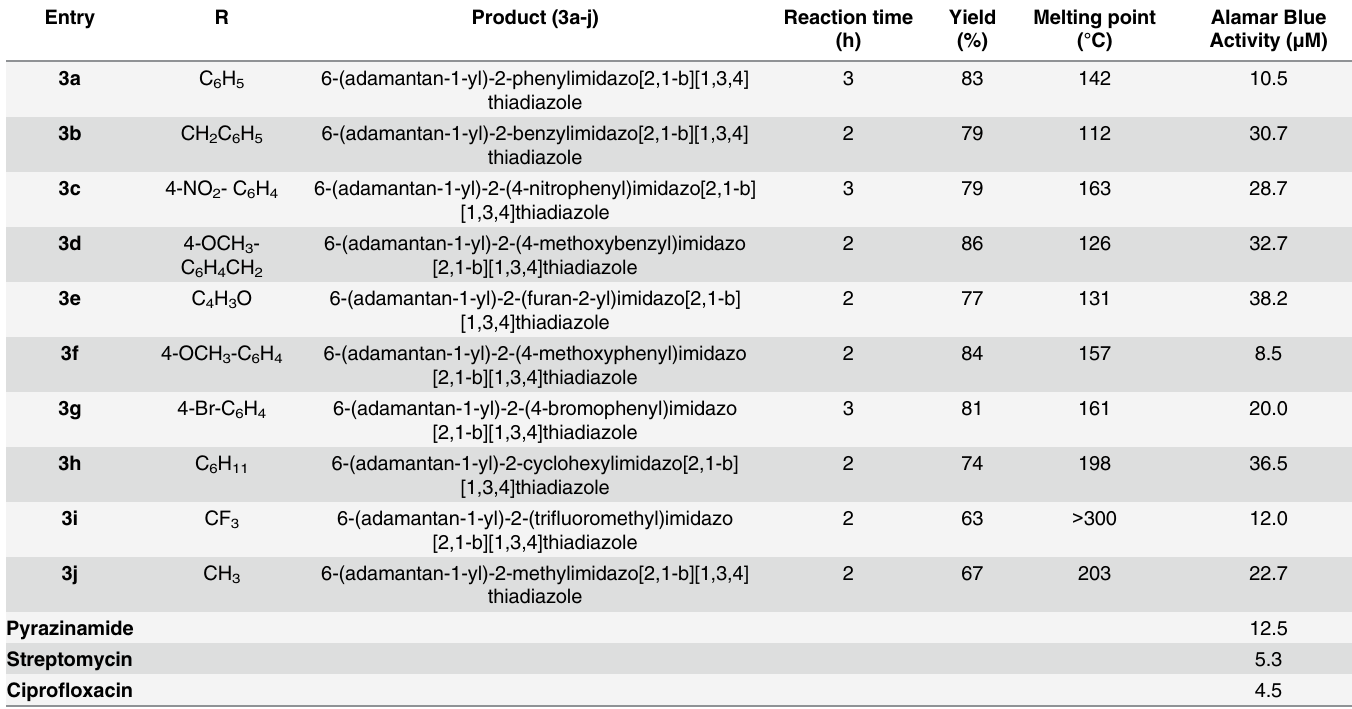
Table 2. Cyclocondensation of 5-alkyl/aryl-2-amino-1,3,4-thiadiazole (1a-j) with 1-adamantyl bromomethylketone to form